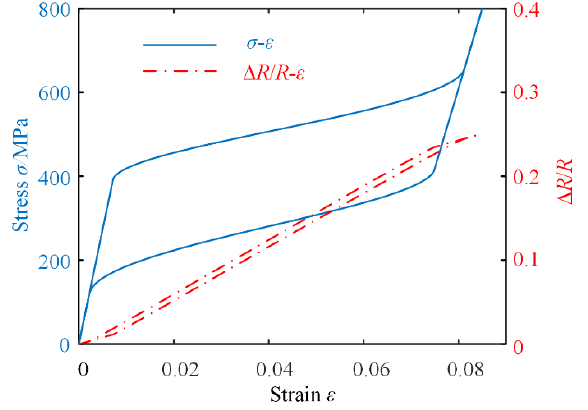
σ - ε and σ - ∆ R / R at 100 ◦